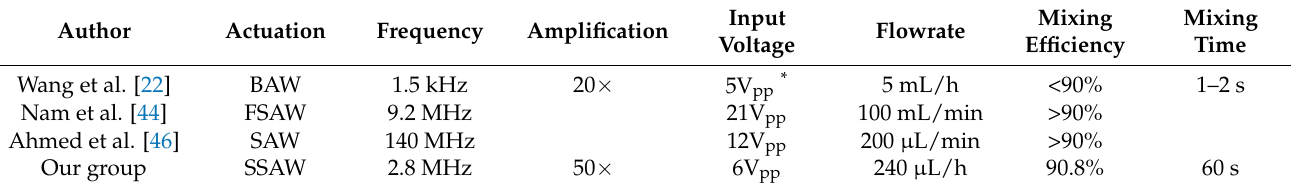
Table 1. Comparison of main parameters with other research.